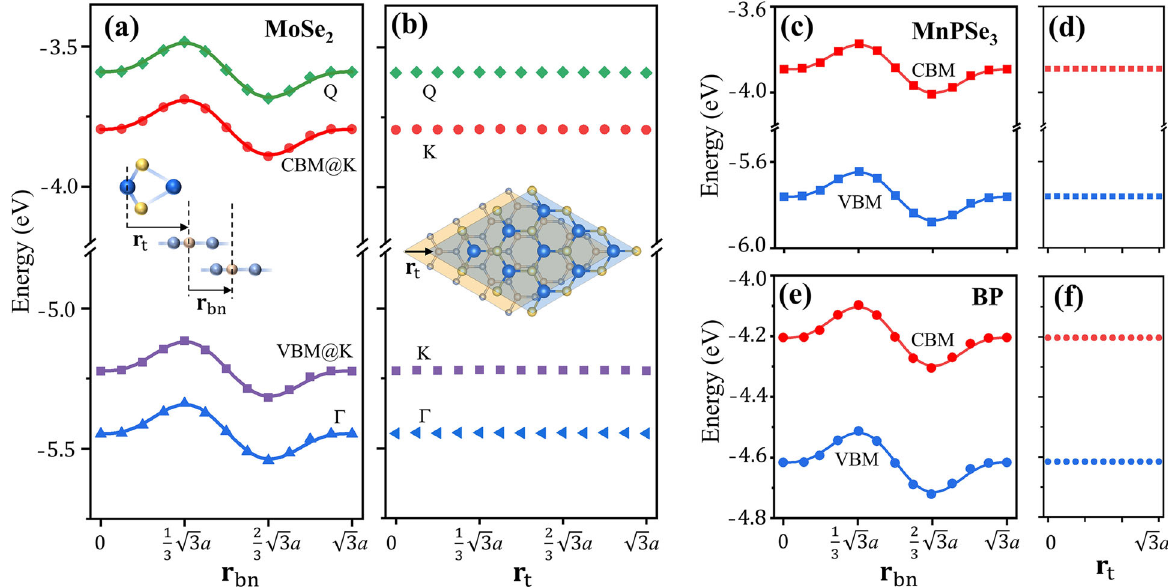
Fig. 3 Universal modulation of band-edge energies in target materials by the electrical polarization in h-BN substrate. a , b Monolayer MoSe 2 on a bilayer h-BN substrate. From DFT-calculated band structures, the energies of conduction band minima (CBM) and valence band maxima (VBM) in MoSe 2 are examined as functions of r bn (registry between the two parallel BN layers, c.f. inset of a ), and r t (stacking registry between MoSe 2 and h-BN, c.f. inset of b ). The expected modulation by the r bn -dependent electrical polarization in h-BN is seen in a . The magnitude of the modulation, i.e., E max − E min , is 193 meV for K and Q valleys, and 202 meV for Γ point. The dependence on r t is not visible in b . The energies of Q and Γ valleys show the same behaviors as the CBM and VBM @ K valleys. c , d and e , f are similar plots for MnPSe 3 and BP monolayer, respectively, on the bilayer h-BN substrate. In c , E max − E min is 233 meV for CBM and 223 meV for VBM. In e , E max − E min is 195 meV for CBM and 207 meV for VBM. See Supplementary Fig. 2 for more